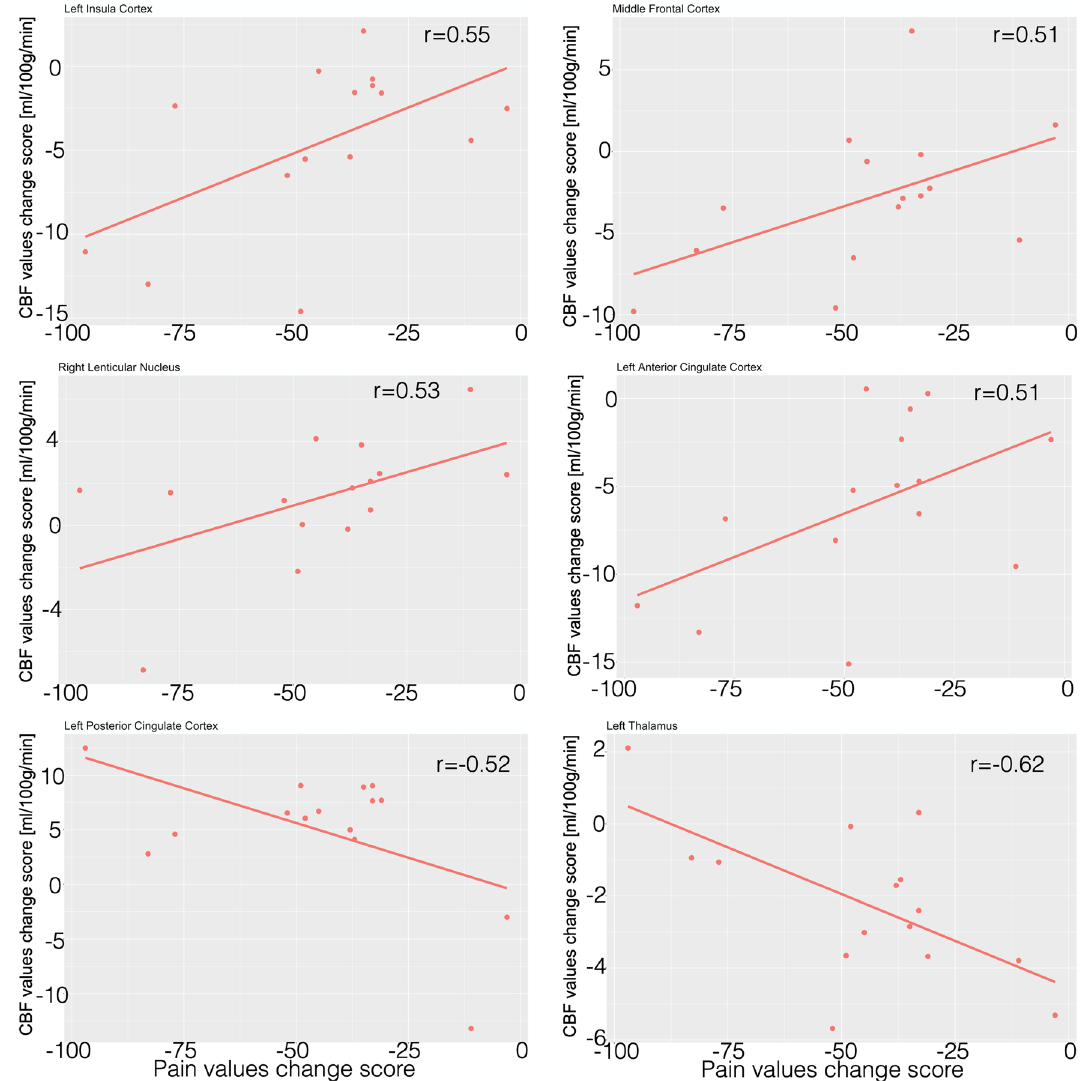
Figure 3. Correlation between rCBF and pain. The figure shows the significant positive and negative correlations between regional cerebral blood flow mean changes within ROI and pain intensity changes in the treatment